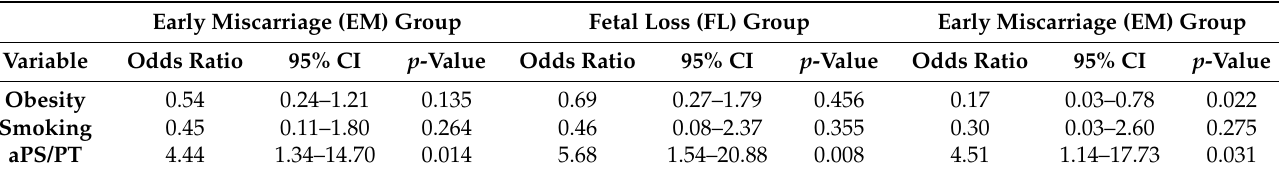
Table 3. Multivariate logistic regression